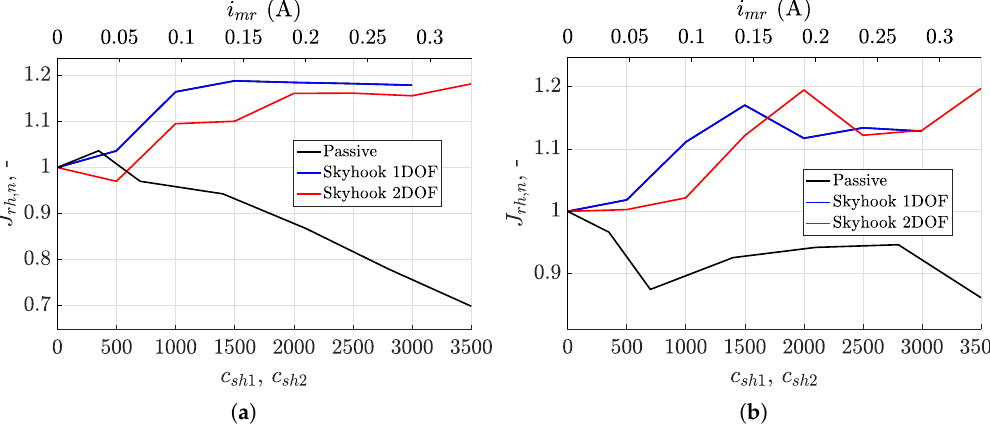
Figure 19. Comparison of road holding for different suspension settings: passive, separate and coupled Skyhook control for vehicle longitudinal velocity of 10 ms − 1 : ( a ) front wheel during braking, ( b ) rear wheel during